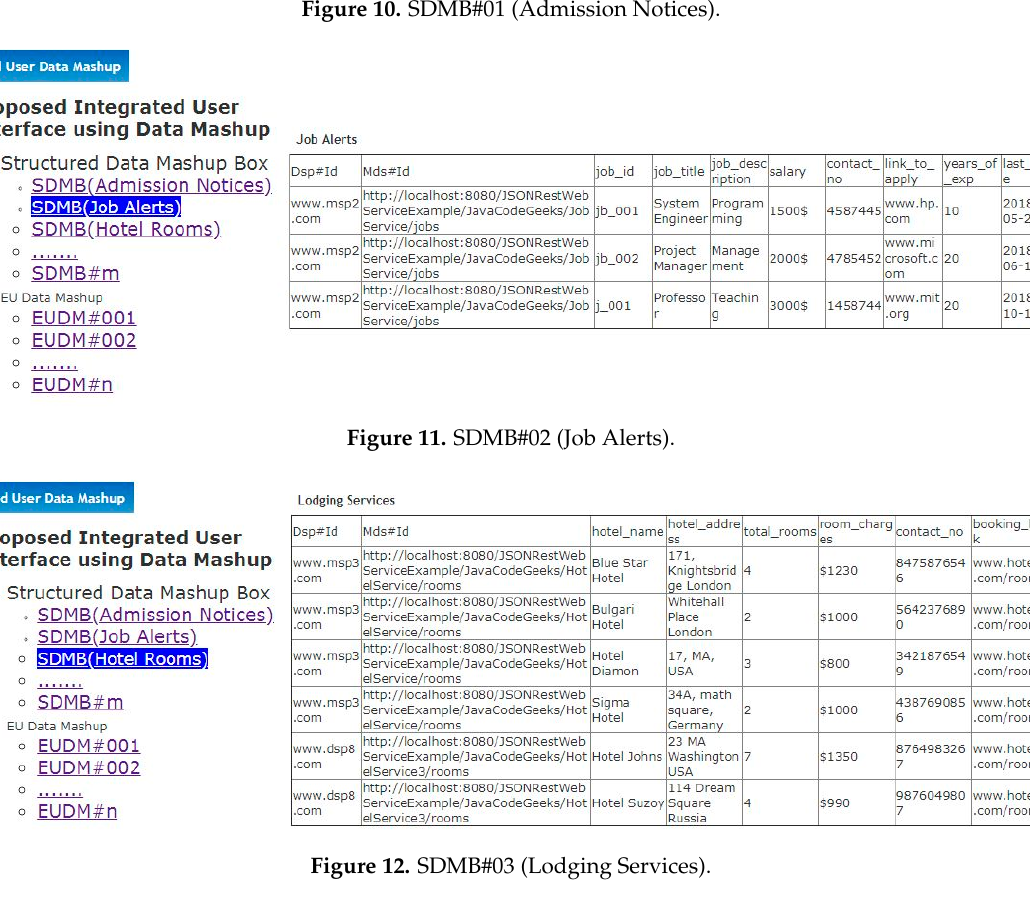
Figure 13. Integrated UI View using EU Data Mashup.